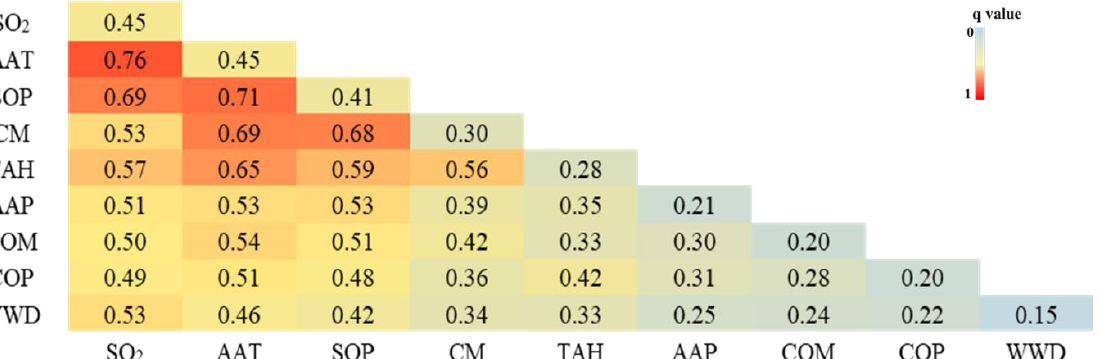
Figure 5. Interaction hotspot maps for factors influencing Brucellosis incidence, 2003–2019. SO 2: total emissions of sulfur dioxide; AAT: average annual temperature; SOP: sheep output; CM: consumption of meat per capita; TAH: total output of animal husbandry; AAP: average annual precipitation; COM: consumption of milk per capita; COP: cattle output; WWD: wastewater discharge.